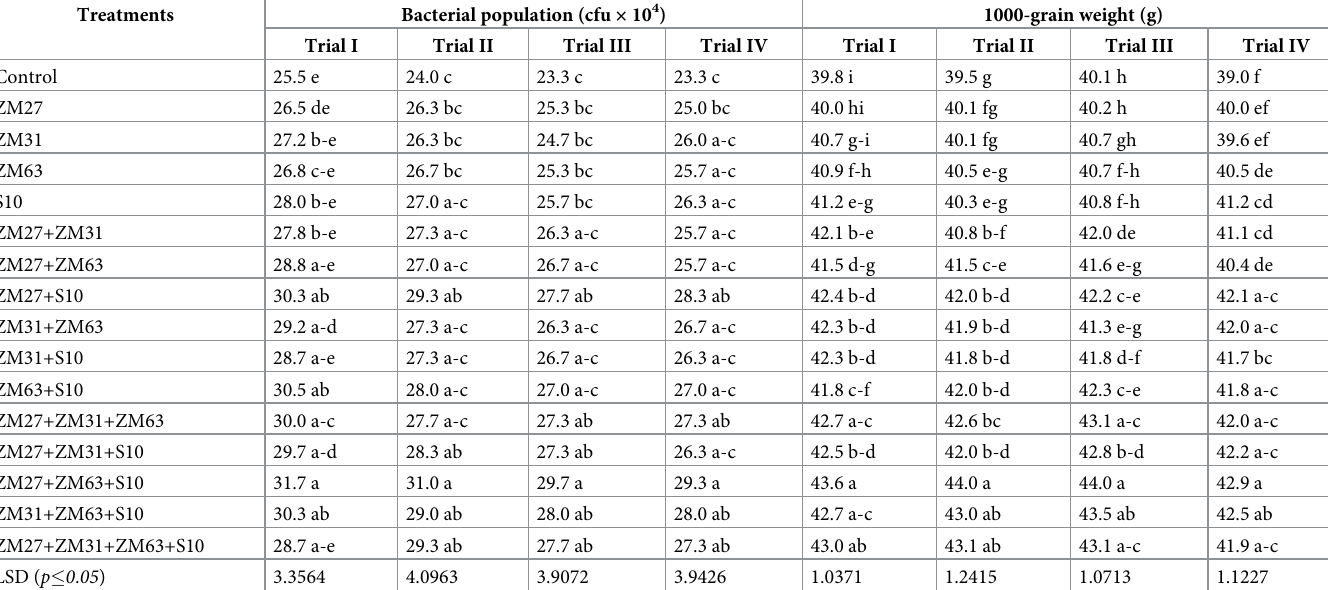
Table 3. Effects of novel bio-inoculants on bacterial population in rhizosphere and 1000-grain weight of wheat in a field trial.